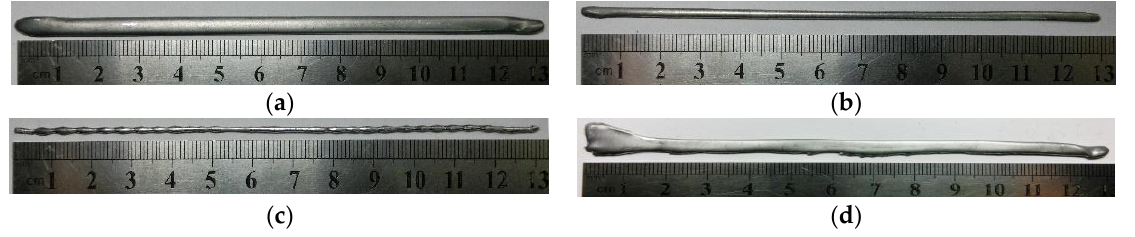
Figure 3. Various forming morphology with different combinations of process parameters. ( a ) Melt flowing. ( b ) Excellent formation. ( c ) Incomplete fusion. ( d ) Uncontrolled area.